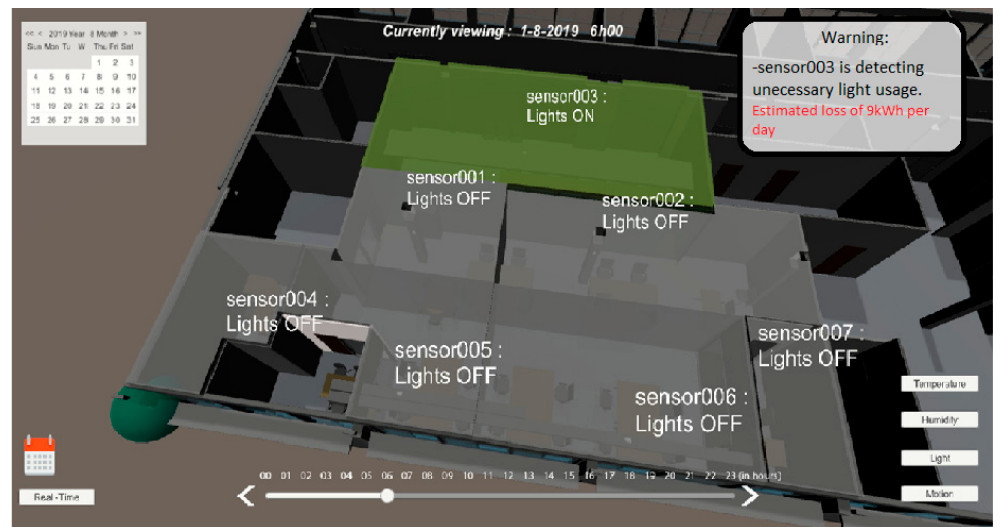
Figure 8. BIM model with light readings per room, where sensor003 presents unnecessary energy usage from artificial light sources and an estimated energy loss of 3 kWh per day, considering the average energy consumption of artificial lights inside the room and the average amount of time people use the room, together with the prediction